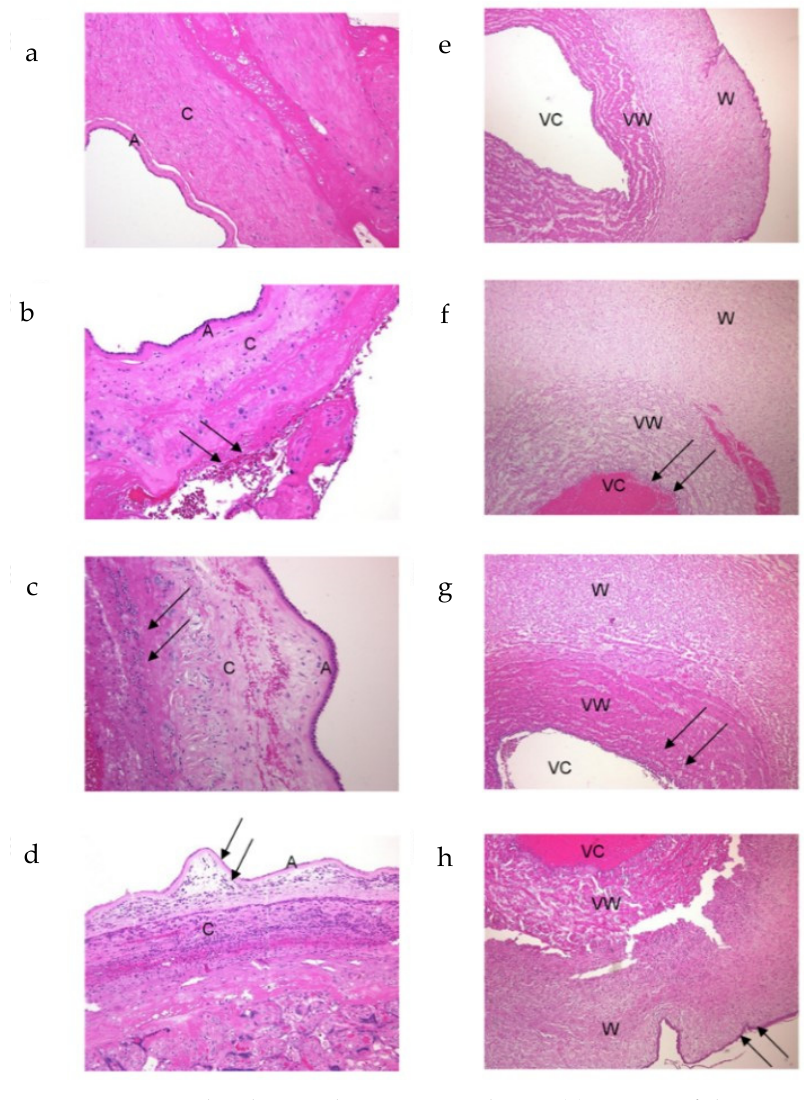
Figure 1. Compared with normal amniotic membranes ( a ), in cases of chorioamnionitis (CAM), ma- ternal leukocytes can be seen to infiltrate membranes, while in cases of funisitis (FN), fetal leukocytes infiltrate and migrate in Wharton jelly. In CAM cases, neutrophils infiltrate the chorionic and amniotic membranes in the following steps: cells are first confined to the subchorionic area (stage I: b ) (arrow); they then migrate to the chorionic membrane (stage II: c ) (arrow); finally, they invade the amniotic membrane and the amniotic space (stage III: d ) (arrow). The polymorph migration that occurs in umbilical cord vessels frequently starts in the vein and then moves to the arteries. Maternal neu- trophils from villi spaces and neonatal-origin cells from umbilical vessels migrated to the chorionic membrane and the amniotic membrane placenta. A: amniotic membrane and C: chorionic membrane. Compared with the normal umbilical cord ( e ), in FN, the following were visible: stage I ( f ), migration and invasion of the vascular walls (stage II: g ) (arrow), and infiltration of Wharton’s jelly (stage III: h ) (arrow). VC: vascular cavity, VW: vascular wall, and W: Wharton’s jelly area. Magnification: 40 × in ( a – d ) and 100 × in ( e – h